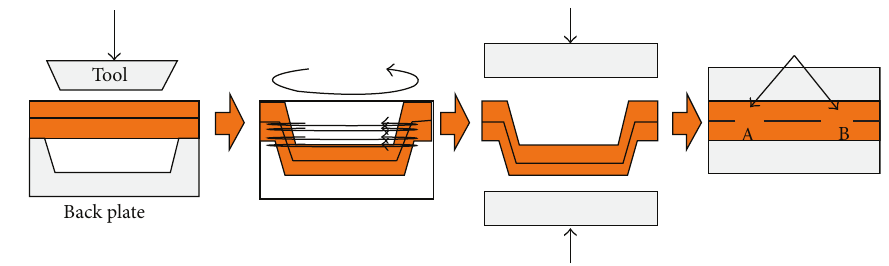
Figure 5: Schematic illustration of the novel FSSW [16].